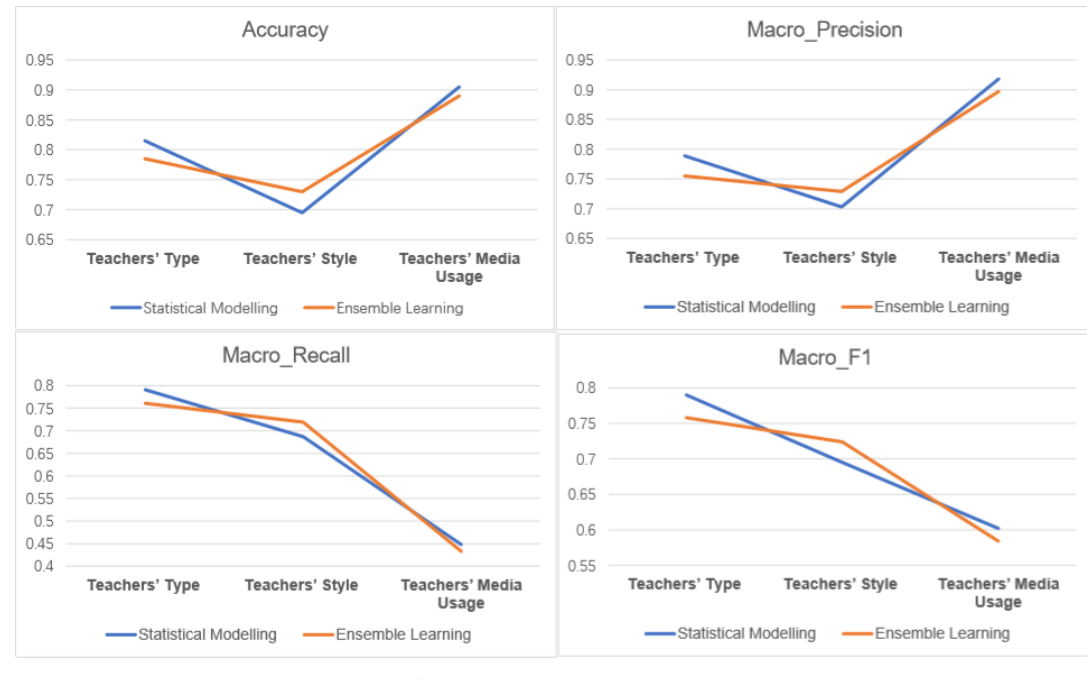
( b ) For category indicators. Figure 13. The performance for score indicators and category indicators. Figure 13. The performance for score indicators and category indicators.